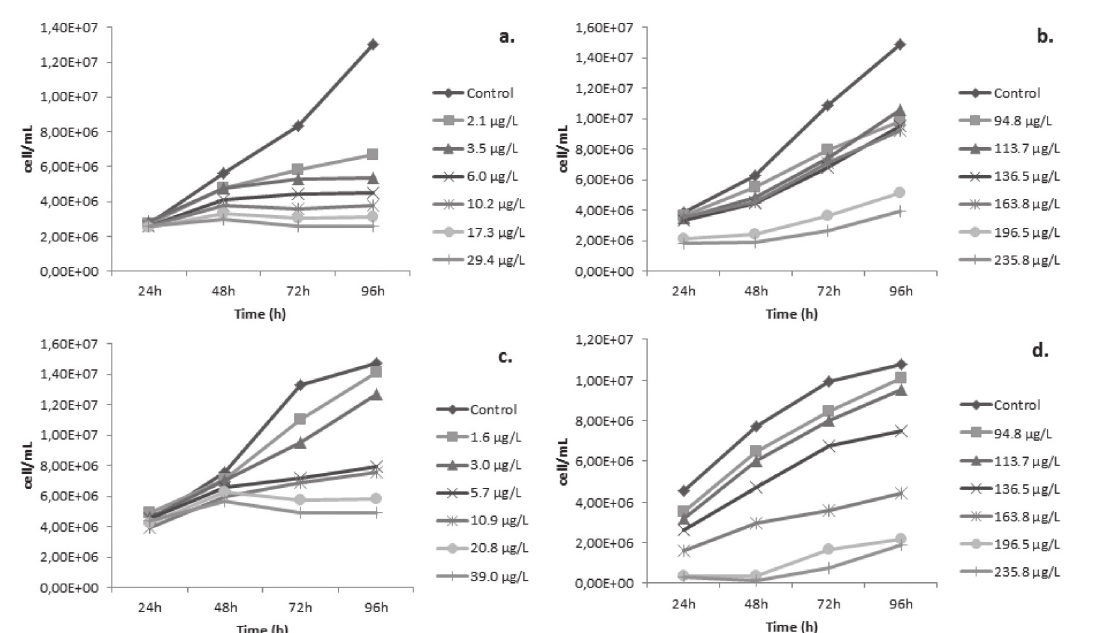
FIGURE 1 - Cellular density of M. aeruginosa exposed to (a) ciprofloxacin or (b) chlorhexidine. Cellular density of M. panniformis exposed to (c) ciprofloxacin or (d)